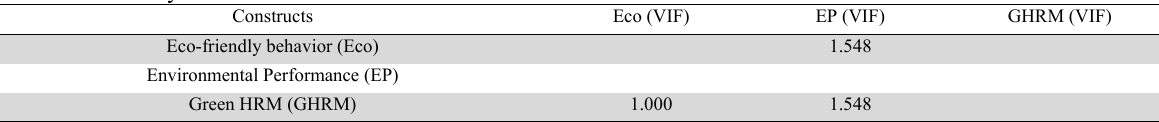
Lateral Collinearity